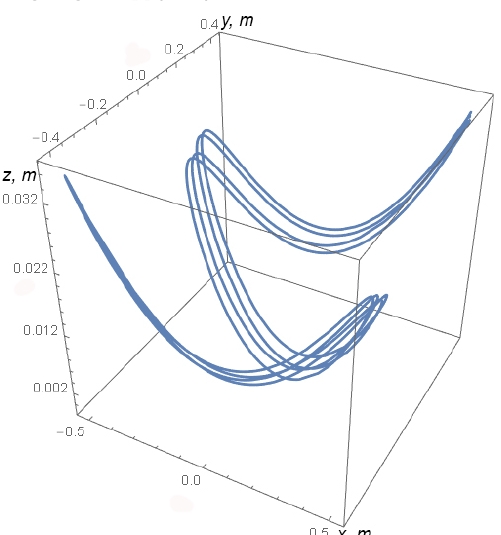
Figure 9. Graph of the total mechanical energy E [ t ] (purple) and Lagrangian L [ t ] (blue) versus time